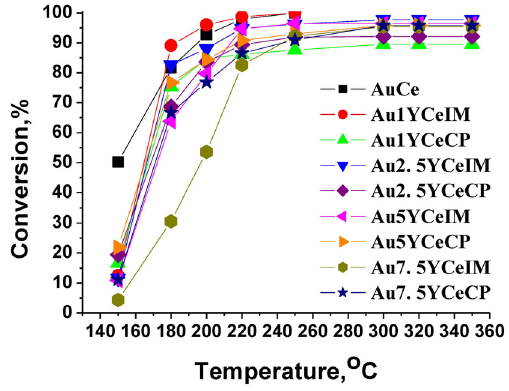
Figure 3. Catalytic activity in CBO after pretreatment in air at 350 °C over studied Y ‐ containing gold catalysts and AuCe.